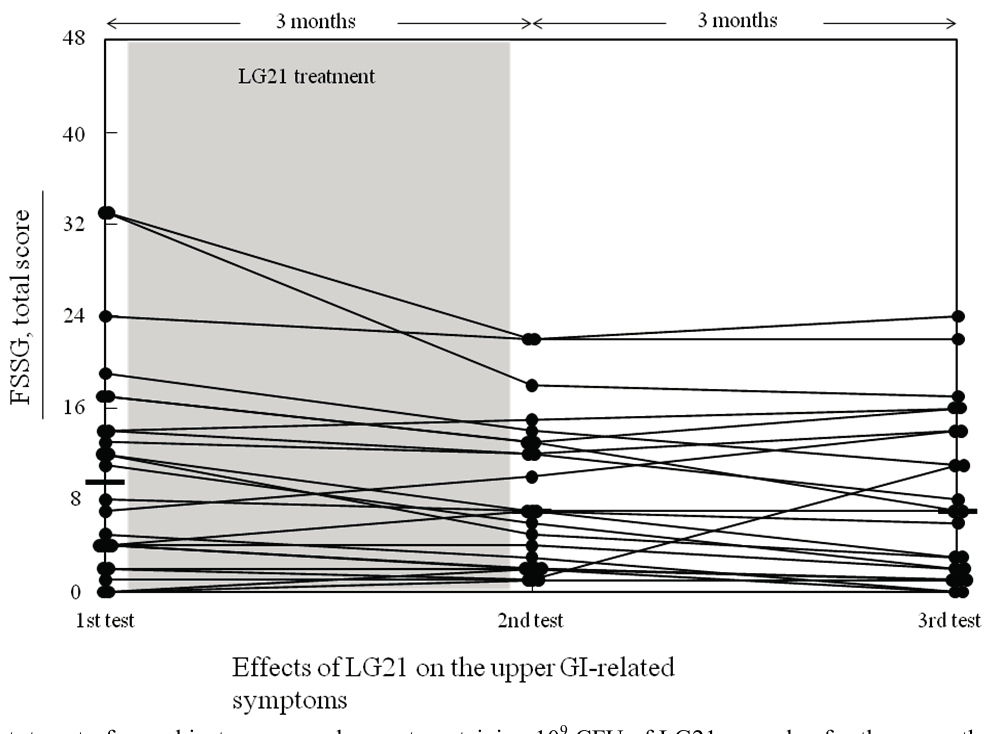
Figure 1. Effects of LG21 on the upper GI-related